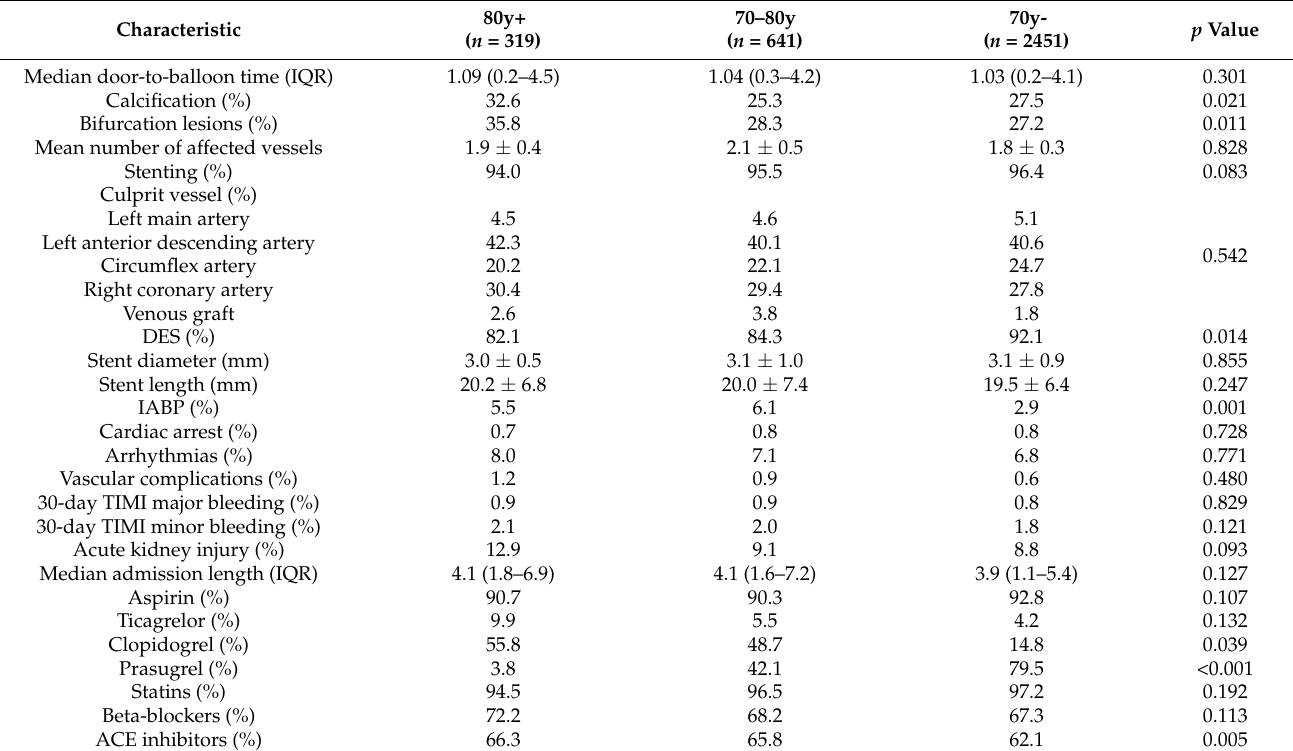
Table 2. Procedural and in-hospital characteristics.